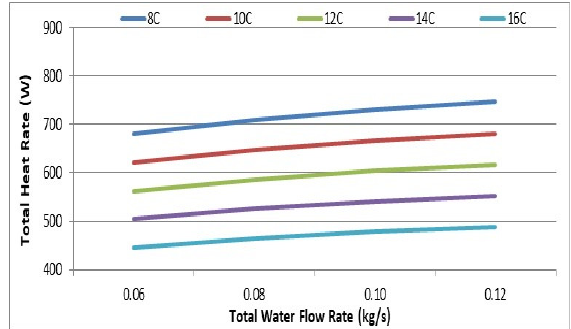
Fig. 7. The total heat rate of terminal units at 8, 10, 12, 14 and 16 °C water supply temperature and valve opening: Valve 1=100%, Valve 2=50 % and Valve 3=100%.